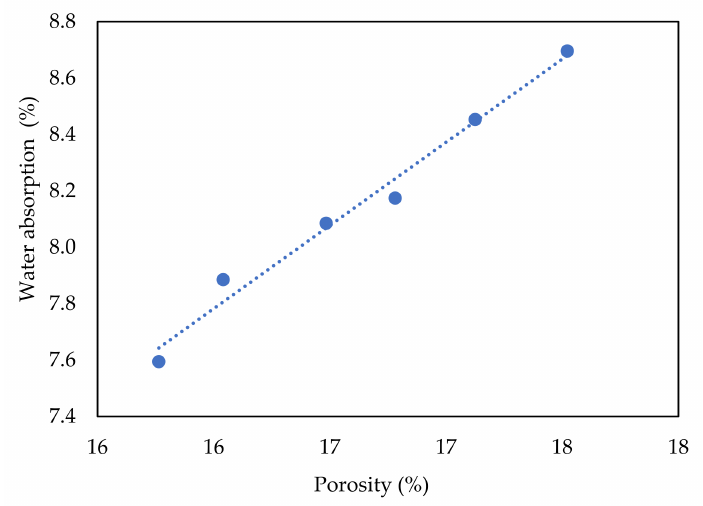
Figure 6. Relationship between porosity and water